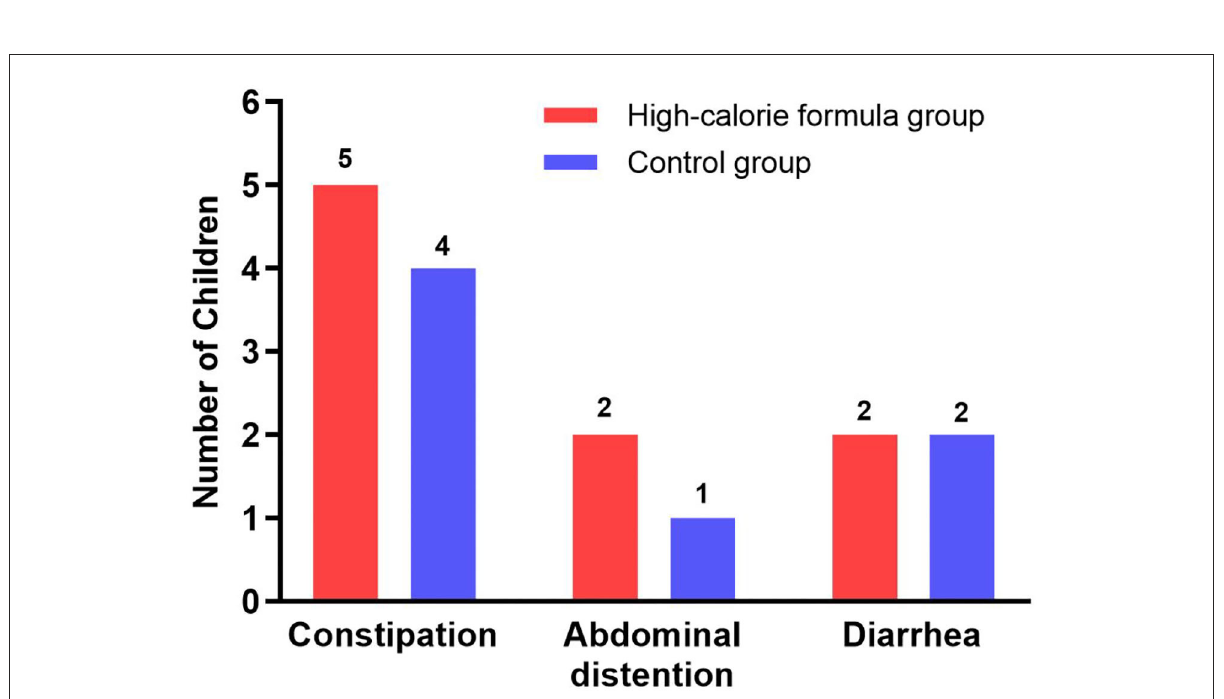
FIGURE4 Gastrointestinal tolerance parameters of the formula and control groups during the study